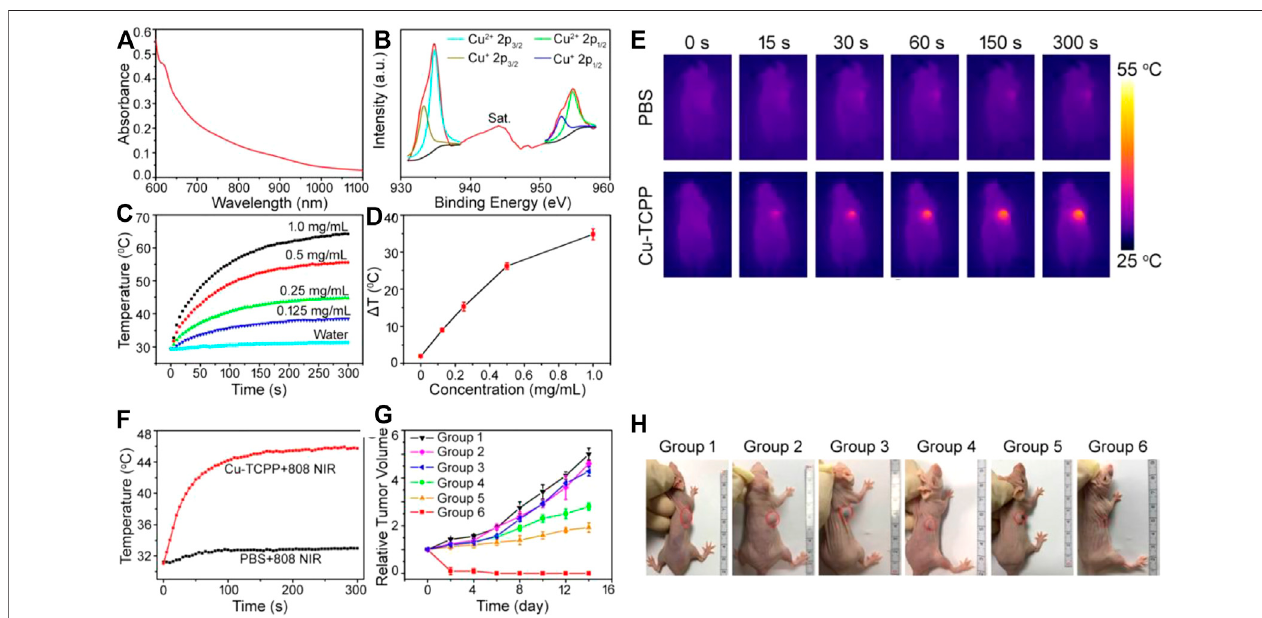
FIGURE4|(A) UVabsorptioncurveofcoppernanosheetMOF. (B) Cu2pXPSspectrumforcoppernanosheetMOF. (C) Heatingcurveofdifferentconcentrations of copper nanosheet MOF. (D) Temperature change curve of different concentrations of MOF material. (E) The light-heat curve of mice with light time. (F) Change of heating curve before and after adding MOFs. (G) Changes in tumor volume in mice after receiving different treatments. (H) Picture of changes in mouse tumor volume after different treatments. 1: PBS; 2: Cu nanosheet; 3: PBS + Laser; 4: Cu nanosheet + PDT; 5: Cu nanosheet + PTT; 6: Cu nanosheet + Laser. Reproduced with permission (Li et al., 2019b). Copyright 2018,